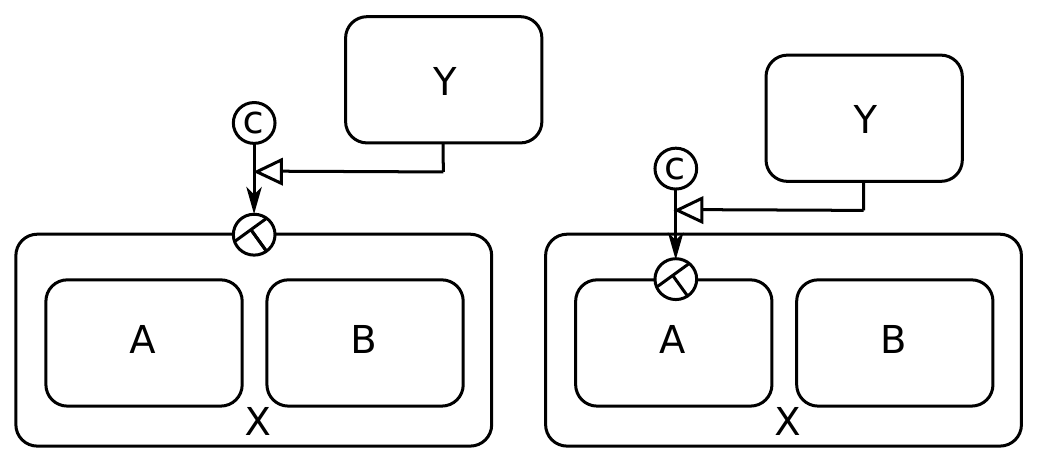
Figure 3.1: On the left, the entity Y causes the whole entity X to translocate to the location c, including its A and B components. On the right, only the entity A is translocated, without effect on B and X.